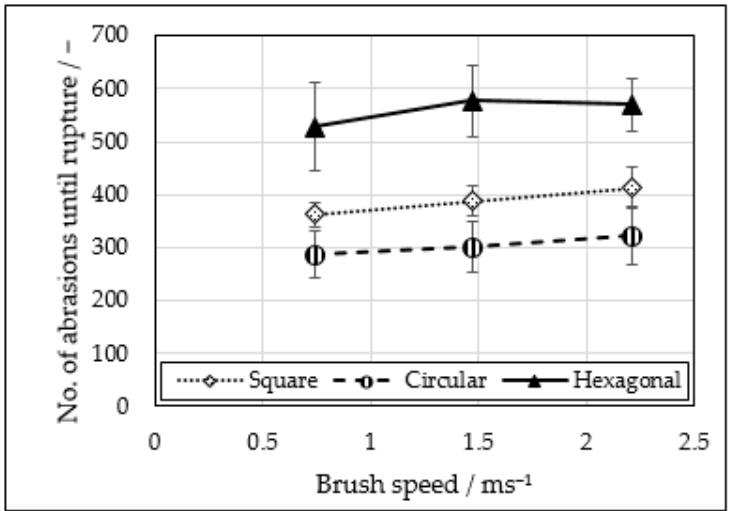
Figure 10. Number of abrasions until rupture of the thin nylon cloth for 0.74, 1.47 and 2.21 ms − 1 for a square, a circular and a hexagonal edge geometry, respectively. a square, a circular and a hexagonal edge geometry,